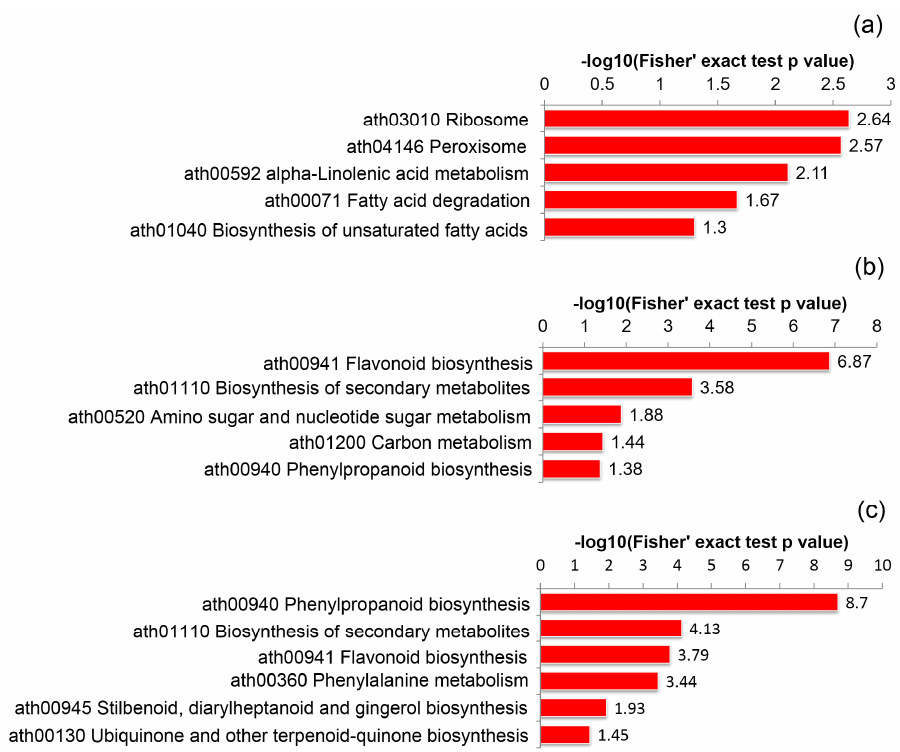
Figure 3. KEGG pathway enrichment analysis of pistils between self- and cross-pollinated in